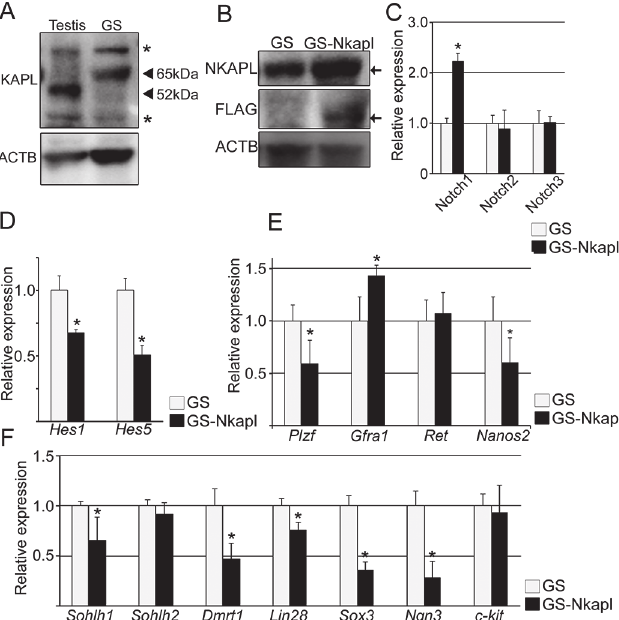
Fig 4. NKAPL suppresses the transcription of downstream target genes through Notch signaling and plays critical roles in spermatogonial stem cell (SSC) maintenance and differentiation. (A) Immunoblotting for proteins extracted from testis or GS cells. Black arrowheads represent the specific reaction for Nkapl antibody. Asterisks represent non-specific reactions. (B) Immunoblotting of GS and GS-Nkapl cells to confirm the expression of the lentiviral-induced Nkapl gene. The reaction with FLAG antibody demonstrates its expression. Black arrows represent the specific reactions by each of the antibodies. (C) The transcriptional changes of Notch1 to 3 between GS and GS-Nkapl cells by qRT-PCR. (D) The transcriptional changes of Hes1 and Hes5 . (E) The transcriptional changes of SSC markers. (F) The transcriptional changes of differentiation-associated factors. Error bars indicate standard deviation from the means. * P <